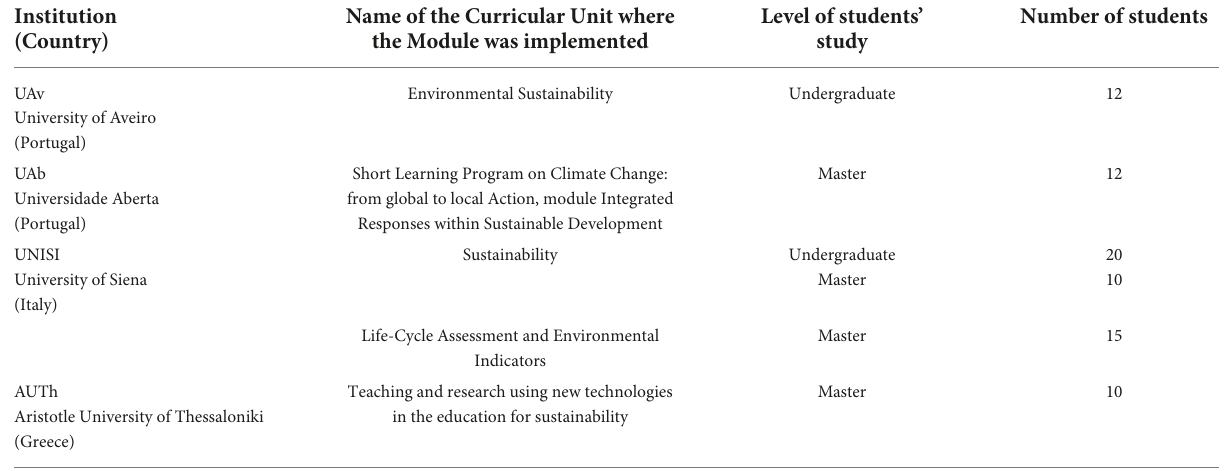
TABLE 1 Module pilot implementation at the four partner universities: courses’ mapping. Institution